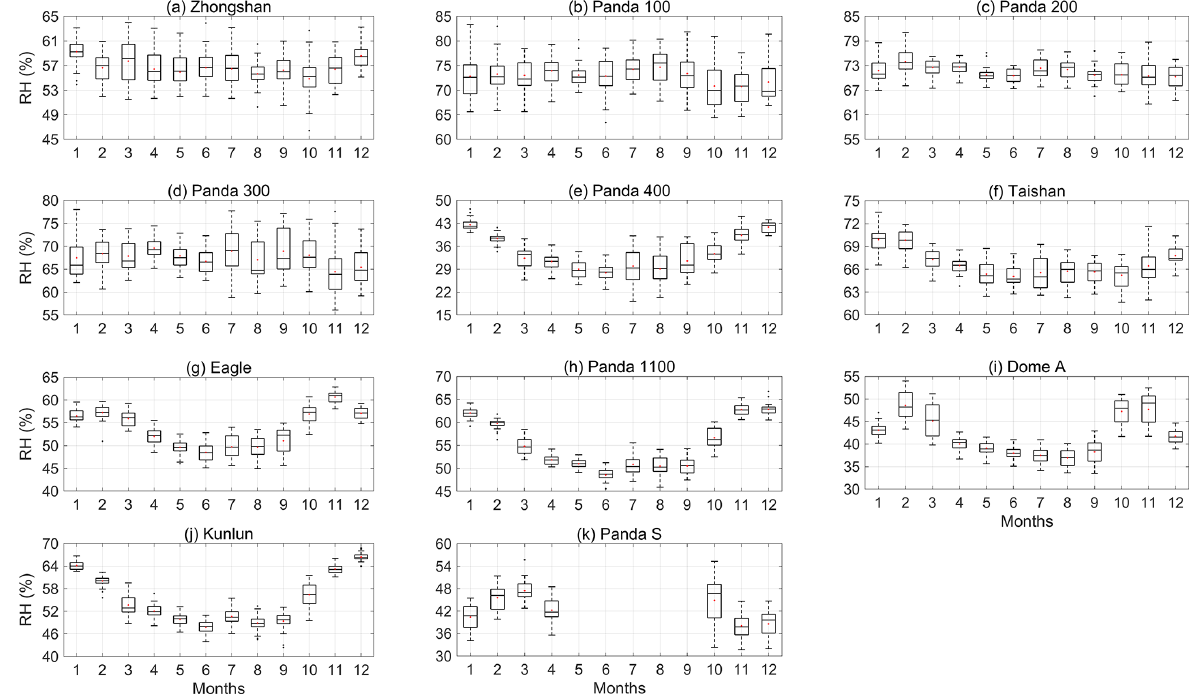
Figure 6. Monthly variation in relative humidity at AWSs in the PANDA network. The calculation periods for these sites are the same as